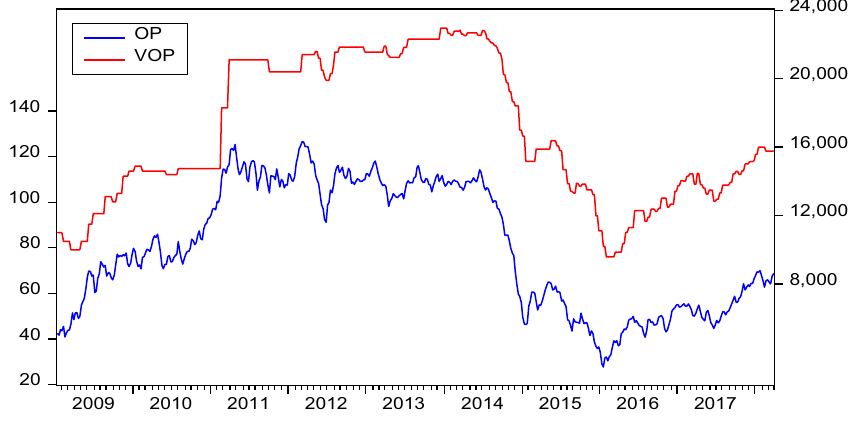
Figure 4. Movements of the world and domestic oil